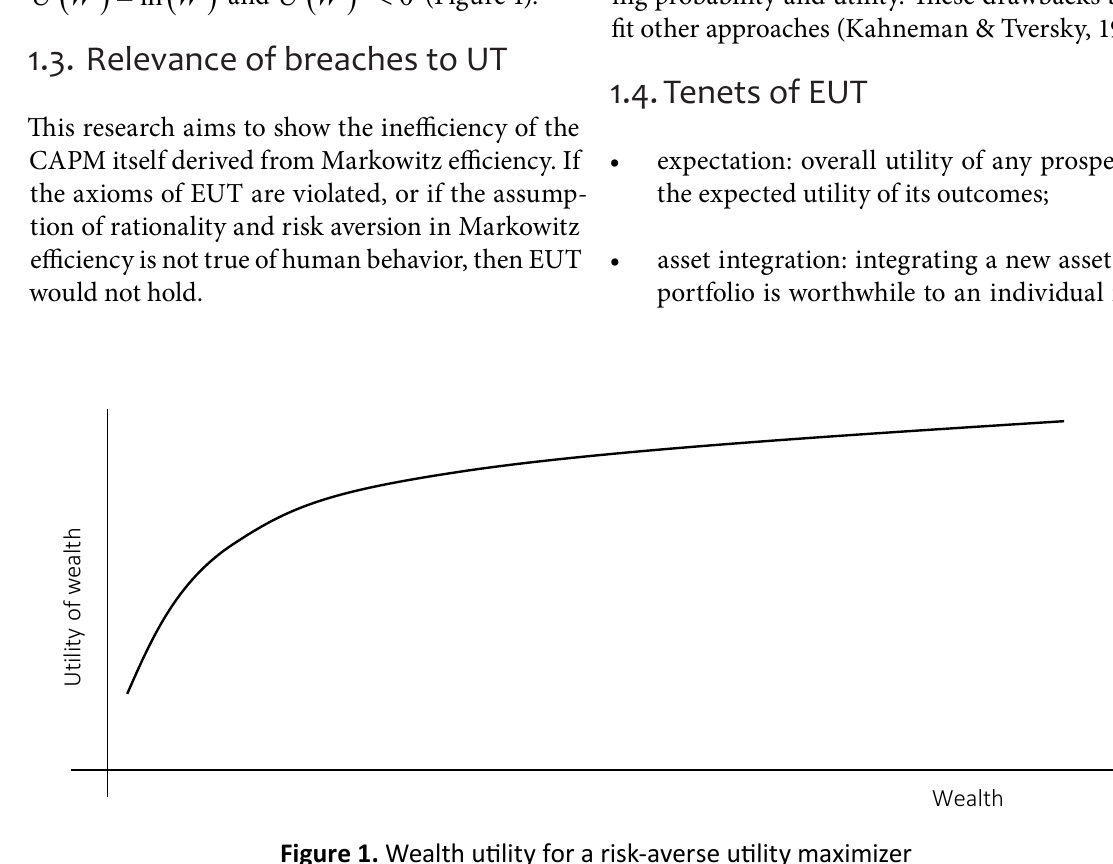
Figure 1. Wealth utility for a risk-averse utility